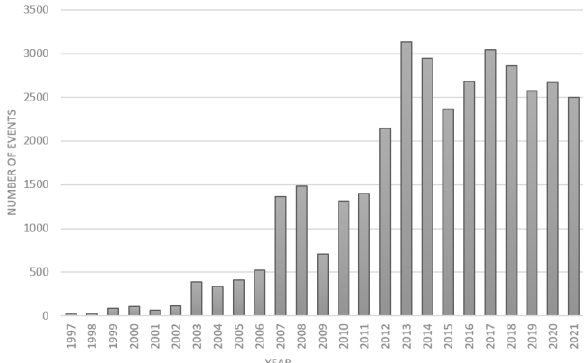
Figure 2. A number of events in the Somalia conflict database from 1997 to 2021.